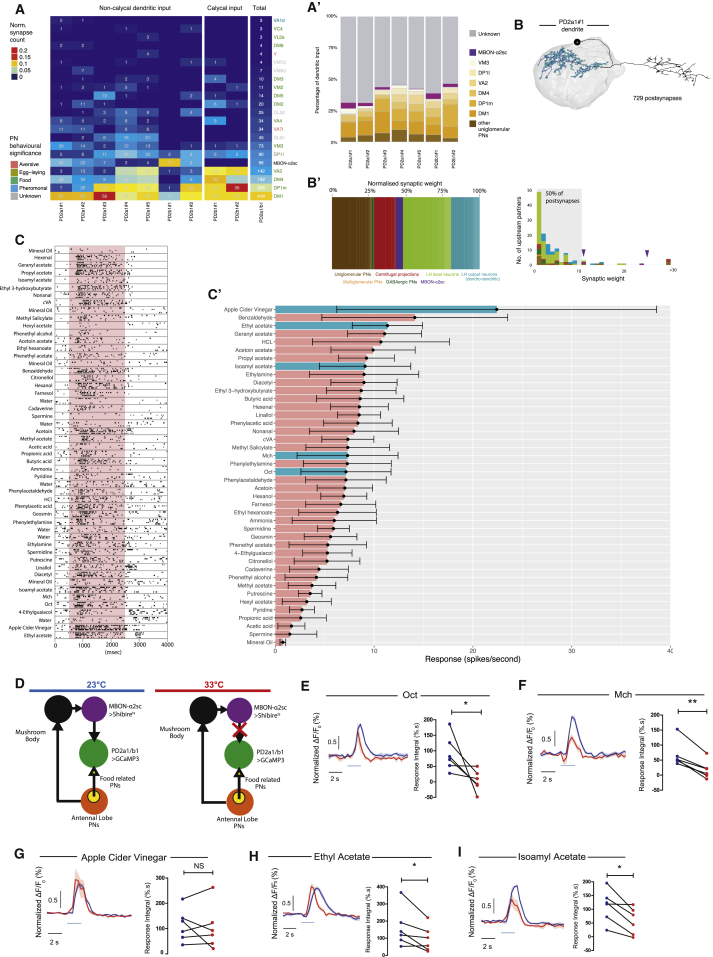
PD2a1 and PD2b1 Receive Input from Appetitive PNs and Are Broadly Tuned(A) Summary heatmap of antennal lobe glomeruli with uniglomerular, excitatory PN connectivity to individual PD2a1 and PD2b1 neurons as determined by EM reconstruction. The connectivity heatmap is separated by neuropil location: PD2a1 and PD2b1 LH dendrites, PD2b1 MB calyx dendrites and total across all PD2a1 and PD2b1 dendrites. Cell numbers represent the number of synapses, and heatmap coloring represents the synapse count normalized by the total number of postsynapses in that neuropil. Uniglomerular PNs with no connectivity are not shown. Uniglomerular PNs from connected glomeruli or MBON-ɑ2sc are ordered by connection strength. PN names are colored by their behavioral significance based on published studies.(A’) The number of synaptic inputs for all PD2a1 and PD2b1 dendrites traced in this study. Input is either undefined (gray), uniglomerular PN (oranges), or MBON-ɑ2sc (purple).(B) Reconstruction of all presynaptic partners to PD2a1#1 in the EM volume. Shown is the PD2a1#1 EM-reconstructed skeleton with dendritic postsynapses highlighted in blue.(B’) Right: stacked bar chart showing the percentages of postsynapses contributed by different types of input neurons (different colors). Left: histogram showing the number of upstream postsynpatic partners against their synaptic weight (number of synapses onto PD2a1#1). The gray box highlights that 50% of PD2a1#1’s postsynapses are spent on neurons that only input PD2a1#1 by less than 10 synaptic connections. MBON-ɑ2sc is indicated by purple arrowheads.(C) Electrophysiological recording raster plot from a representative PD2a1 neuron. The responses of each cell to the different odors are stacked, black squares represent action potentials, and there are 4 presentations of each odor. The red block represents the odor stimulation period.(C’) Tuning curve of PD2a1 and PD2b1 neurons. Responses are shown in hertz. Data are mean ± SEM; n = 7 cells, consisting of one PD2b1, one PD2a1 or PD2b1, and five PD2a1 neurons. Odors in the text are shown in cyan.(D) Schematic for imaging experiments with MBON-ɑ2sc silencing. Flies express Shits in MBON-ɑ2sc and GCaMP3 in PD2a1 and PD2b1 neurons for calcium imaging. At the permissive temperature (left), there is no effect on MBON-ɑ2sc neurotransmission, and PD2a1 and PD2b1 neurons receive input from both MBON-ɑ2sc and directly from the antennal lobe. MBON-ɑ2sc is silenced at the restrictive temperature (right), although the PD2a1 and PD2b1 neurons still receive input from the antennal lobe.(E) Response of PD2a1 and PD2b1 axons to Oct with or without MBON-ɑ2sc silencing. Left: time traces of normalized GCaMP3 fluorescence (STAR Methods) are shown at permissive (blue) and restrictive (red) temperature in response to Oct stimulation (light blue bar). Right: the integral of the absolute odor responses for each fly at the permissive (blue) and restrictive (red) temperatures are plotted, which revealed decreased response to Oct after MBON-ɑ2sc silencing (n = 6, paired t test = 0.044).(F) Response of PD2a1 and PD2b1 axons to Mch with or without MBON-ɑ2sc silencing. The layout of the data is the same as in (E). This revealed a decreased response to Mch after MBON-ɑ2sc silencing (n = 6, paired t test = 0.0015).(G) Response of PD2a1 and PD2b1 axons to vinegar with or without MBON-ɑ2sc silencing. The layout of the data is the same as in (E). There was no change in response to vinegar after MBON-ɑ2sc silencing (n = 6, paired t test = 0.67).(H) Response of PD2a1 and PD2b1 axons to ethyl acetate with or without MBON-ɑ2sc silencing. The layout of the data is the same as in (E). This revealed a decreased response to ethyl acetate after MBON-ɑ2sc silencing (n = 6, paired t test = 0.039).(I) Response of PD2a1 and PD2b1 axons to isoamyl acetate with or without MBON-ɑ2sc silencing. This revealed a decreased response to isoamyl acetate after MBON-ɑ2sc silencing (n = 6, paired t test = 0.012).∗p < 0.05, ∗∗p < 0.01. See also Figure S10.